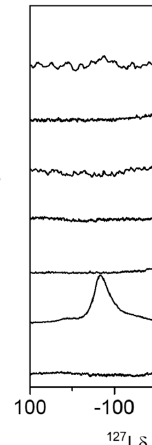
Figure 3. SEM images of the representative products synthesized by the interzeolite transformation of Na-A and Na-X (left), and the interconversion products of CH 3 I adsorbed Na-A, Ag-A, Na-X, and Ag-X (right).